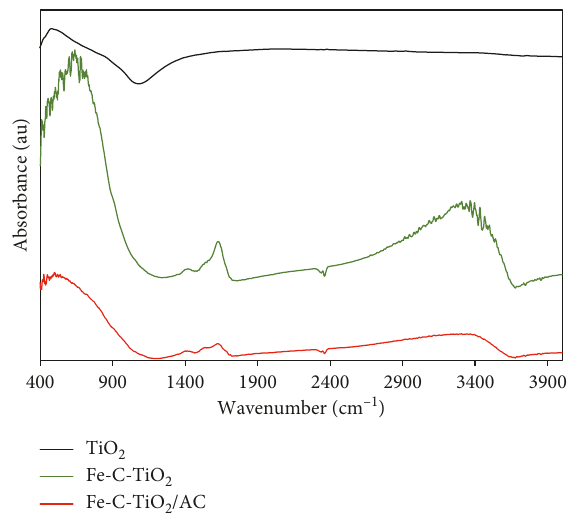
Figure 5: IR spectra of Fe-C-TiO